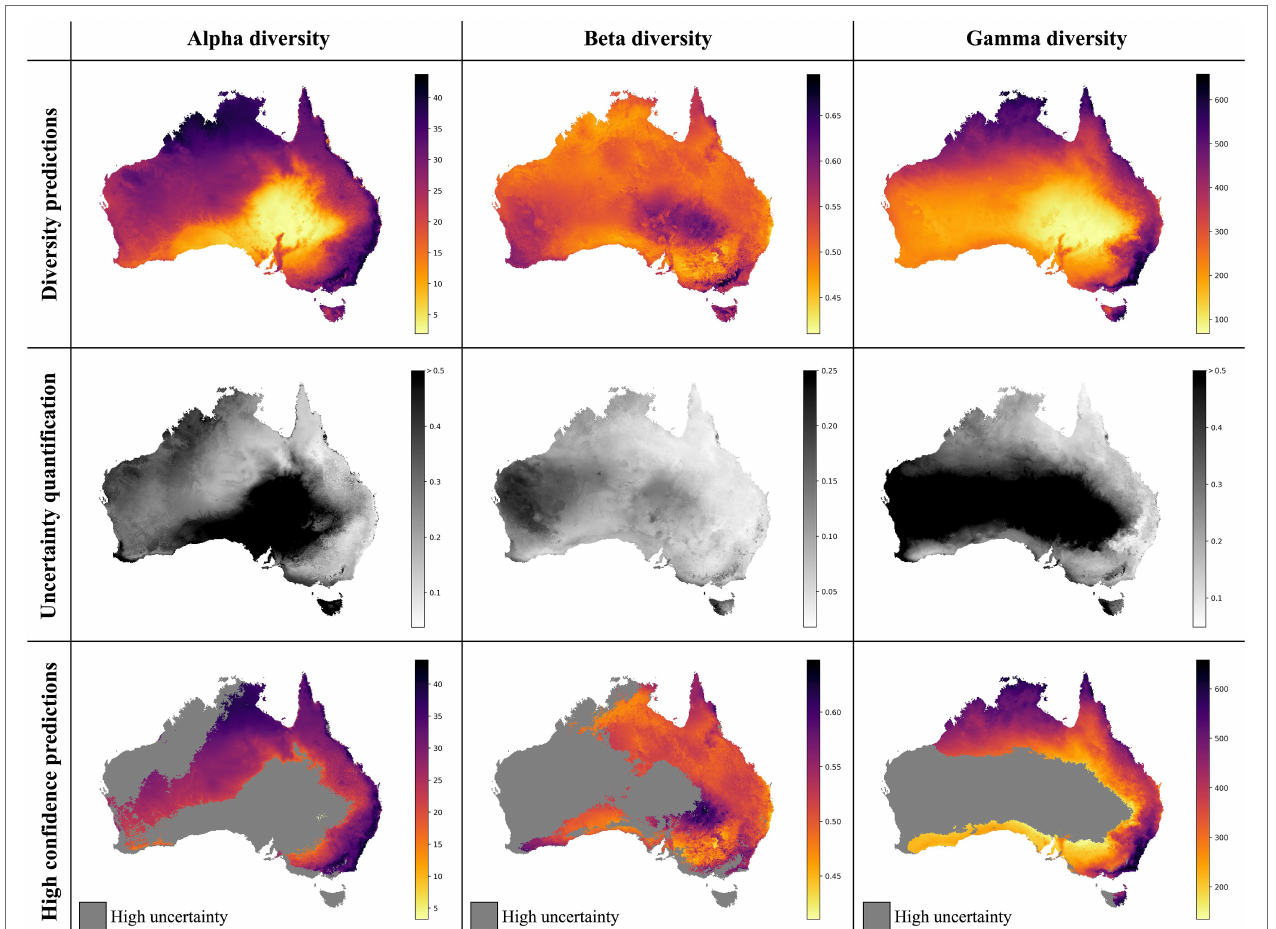
FIGURE 4 | Neural Network predictions for alpha, beta, and gamma diversity of vascular plants. The neural network models were trained separately on alpha, beta, or gamma diversity estimates, which we compiled from available vegetation plot data ( Figure 1 ). The alpha diversity maps (left column) show the number of vascular plant species expected to be found in a 500-m 2 plot (most common plot-size found in the vegetation plot data; Supplementary Figure S2 ). The beta diversity maps (center column) quantifies the spatial turnover and differences in species compositions (Sørensen dissimilarity index, relative to the total diversity) between such 500 m 2 plots within each grid cell (10 × 10 km). The gamma diversity maps (right columns) show the total species richness within each grid cell. The top row shows the predictions averaged across an ensemble of 50 independently trained models, using different starting seeds. The center row shows the coefficient of variation for each grid cell, as a measure of prediction uncertainty. High values (dark grey/black) correspond to grid cells with less consistent diversity predictions. The bottom row shows the average diversity predictions for only those grid cells with the most consistent diversity predictions (coefficient of variation smaller than median across all grid cells), while high-uncertainty grid cells are marked in